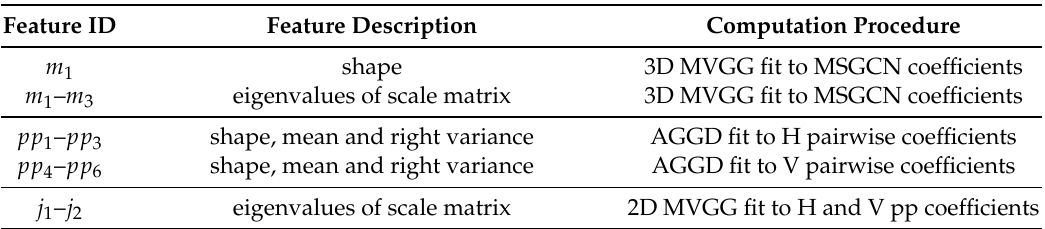
Table 7. Feature summary for joint MSGCN ( m ), paired-products ( pp ) and joint paired-products ( j ) coefficients for the X-ray application. All features are extracted at two scales.